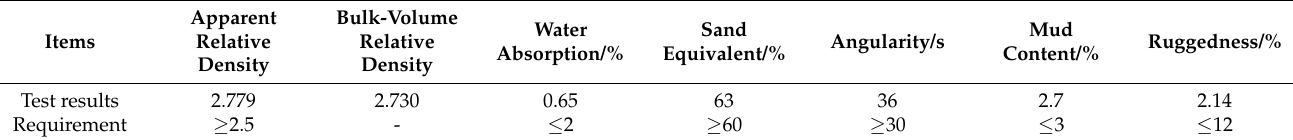
Table 6. Technical requirements and test results of fine aggregate.